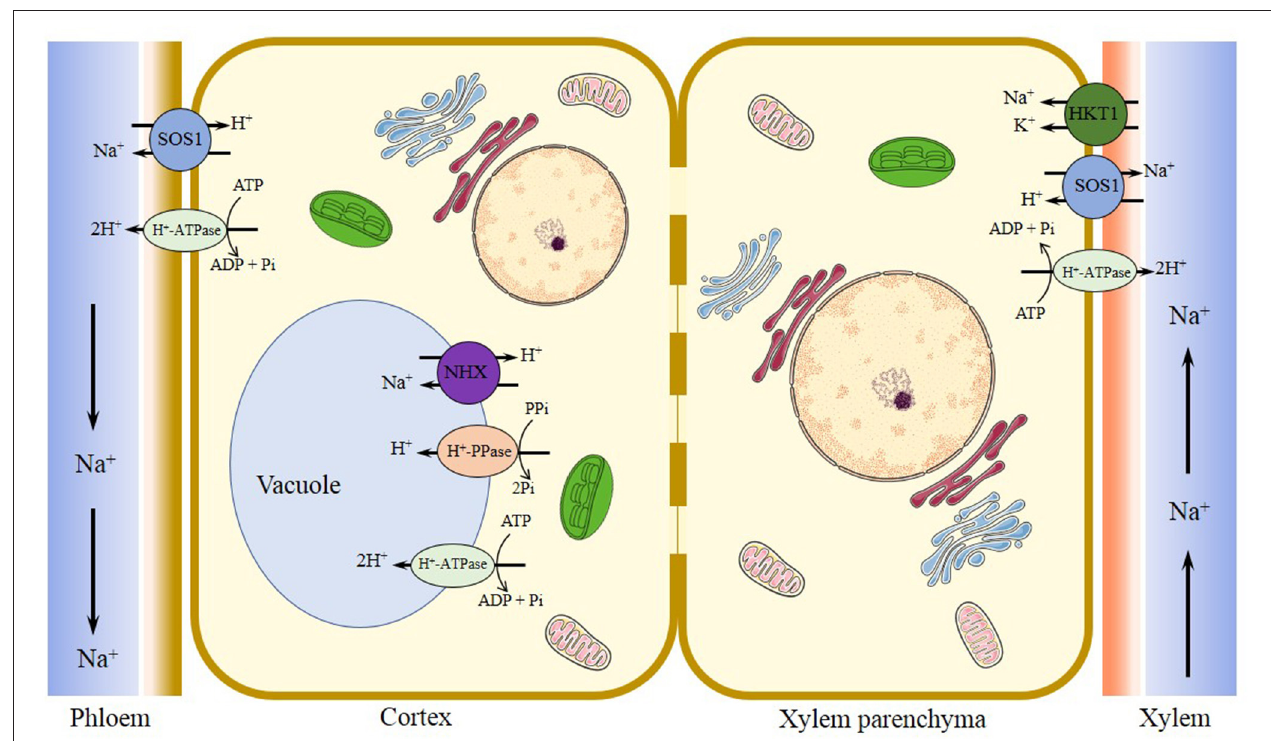
FIGURE 3 | Major transporters regulating Na + / K + homeostasis in Eutrema under salinized tissues. Plasma membrane Na + /H + antiporter SOS1 functions in the regulation of ion homeostasis by extruding excessive Na + out of cells, facilitating Na + loading into the xylem in roots and shoots, and reducing the transfer of Na + from roots to shoots, to counterbalance the uptake of Na + . Tonoplast-localized Na + /H + exchanger NHX1 driven by vacuole H + -PPase (VP1) and/or H + -ATPase (V-ATPase) proton pumps is responsible for the sequestration of Na + into the vacuole, to reduce the concentration of Na + in the cytosol. The halophytic Eutrema HKT1;2 (EsHKT1;2 and EpHKT1;2) is considered as the Na + /K + co-transporter, that function in Na + retrieval from the xylem vessels under salt stress, and helps sequester ions into xylem parenchyma cells to protect photosynthetic tissues. SOS1, salt overly sensitive 1 (a plasma membrane Na + /H + antiporter); NHX, vacuolar Na + /H + antiporter; V-ATPase, vacuolar H + -ATPase; V-PPase, vacuolar H + -translocating inorganic pyrophosphatase (vacuolar H + -pyrophosphatase); HKT1, group 1 high-affinity K +